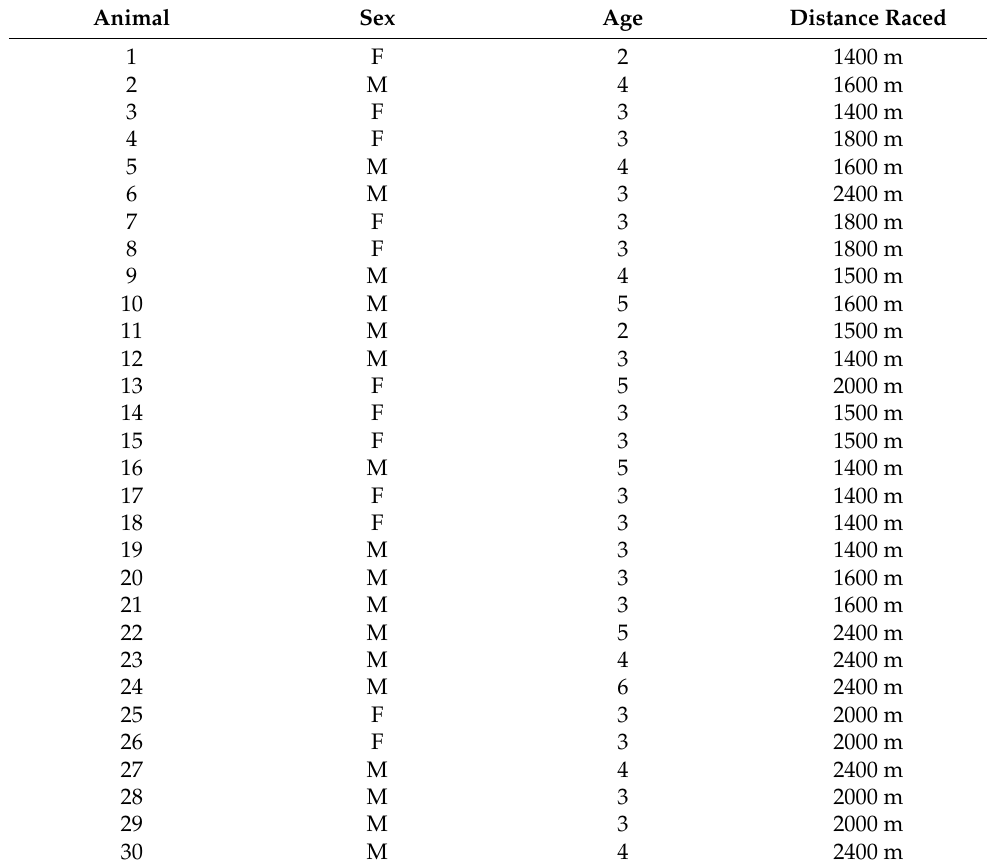
Table 1. Studied animals’ sex, age (in years), and distance raced in meters. Animal Sex